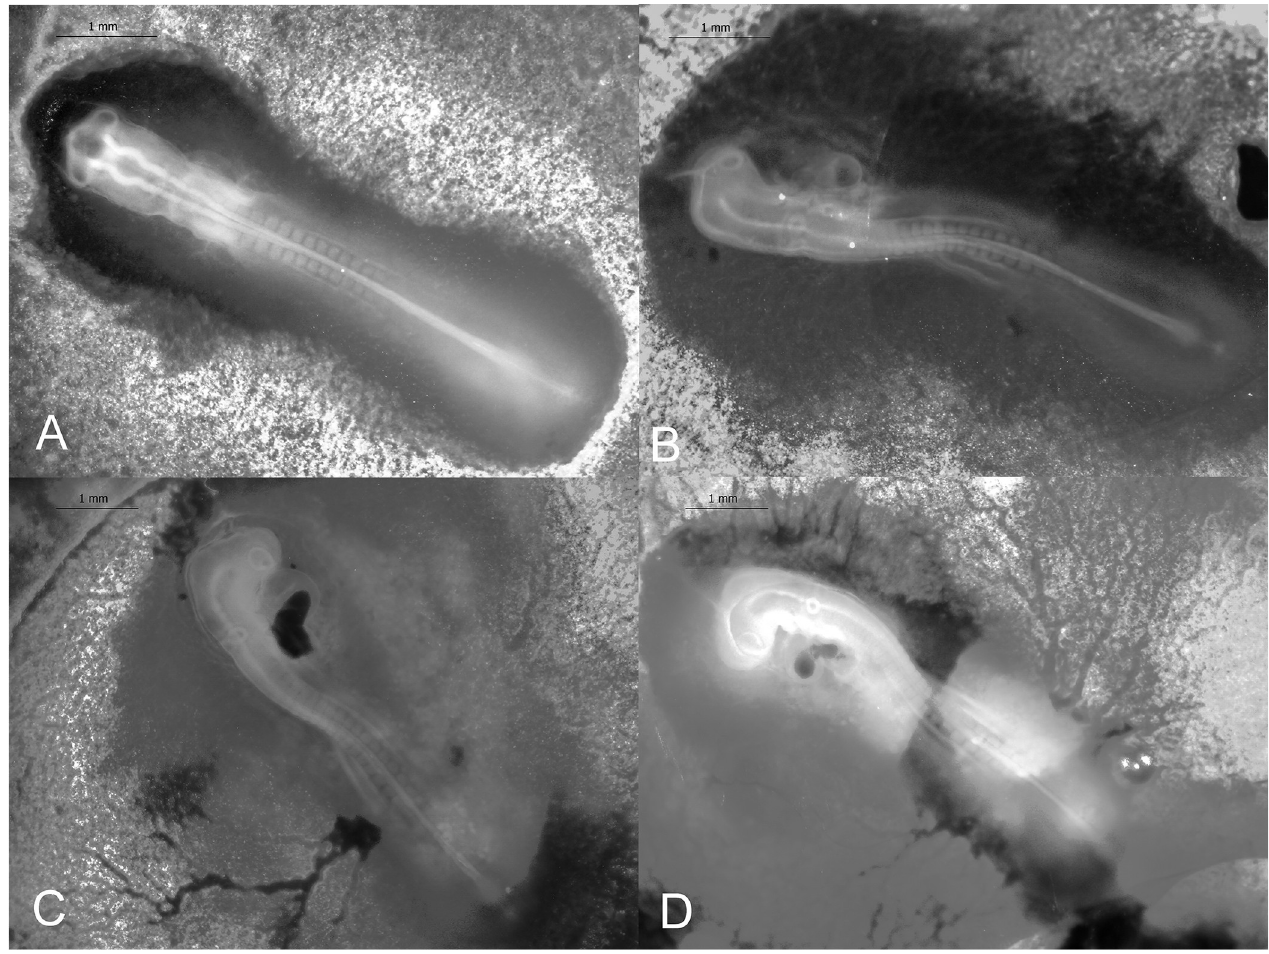
Fig 4. Stages 11–14 (52–60 h) of the California valley quail’s embryological stages of development. (A) Stage 11, 13 somite pairs visible. (B) Stage 12, 16 somite pairs visible. Telencephalon, optic vesicles, and auditory pit visible. (C) Stage 13, 19 somite pairs present. Telencephalon and heart more prominent than previous stage. (D) Stage 14, 22 somite pairs present. Optic lens, and Rathke’s pouch can be identified. bud length: 0.97 ± 0.05 mm ( N = 4). Leg-bud width: 0.29 ± 0.02 mm ( N = 4). Embryo length: 6.13 ± 0.40 mm ( N = 5; Fig 6B). Stage 21 (102–108 h). Both wing- and leg-buds slightly asymmetrical and enlarged. Poste- rior contours of wing- and leg-buds are close to 90˚. Anterior contour are ~45˚. Maxillary pro- cess distinct and exceeds the mandibular process. The 4th cleft is present as a slit. Allantois has become vesicular. Eye pigmentation still faint. Wing-bud length: 1.13 ± 0.03 ( N = 7). Wing- bud width: 0.49 ± 0.05 mm ( N = 7). Leg-bud length: 1.05 ± 0.05 mm ( N = 5). Leg-bud width: 0.50 ± 0.10 mm ( N = 5). Embryo length: 6.79 ± 0.10 mm ( N = 3; Fig 6C). Stage 22 (114–120 h). Posterior contours of leg- and wing-buds are steeper than anterior contours. Circumference of eye is darkened with pigment. Wing-bud length: 1.07 ± 0.03 mm ( N = 3). Wing-bud width: 0.88 ± 0.05 mm ( N = 3). Leg-bud length: 1.23 ± 0.06 mm ( N = 3). Leg-bud width: 0.86 ± 0.27 mm ( N = 3). Embryo length: 7.10 ± 0.15 mm ( N = 3; Fig 6D). Stage 23 (114–120 h). Both wing- and leg-buds equal in length. Anterior and posterior contours run parallel. Both wing- and leg-buds approximately equal in length as width. Maxil- lary process lengthened. The dorsal contour of the entire body from the hindbrain to tail is a